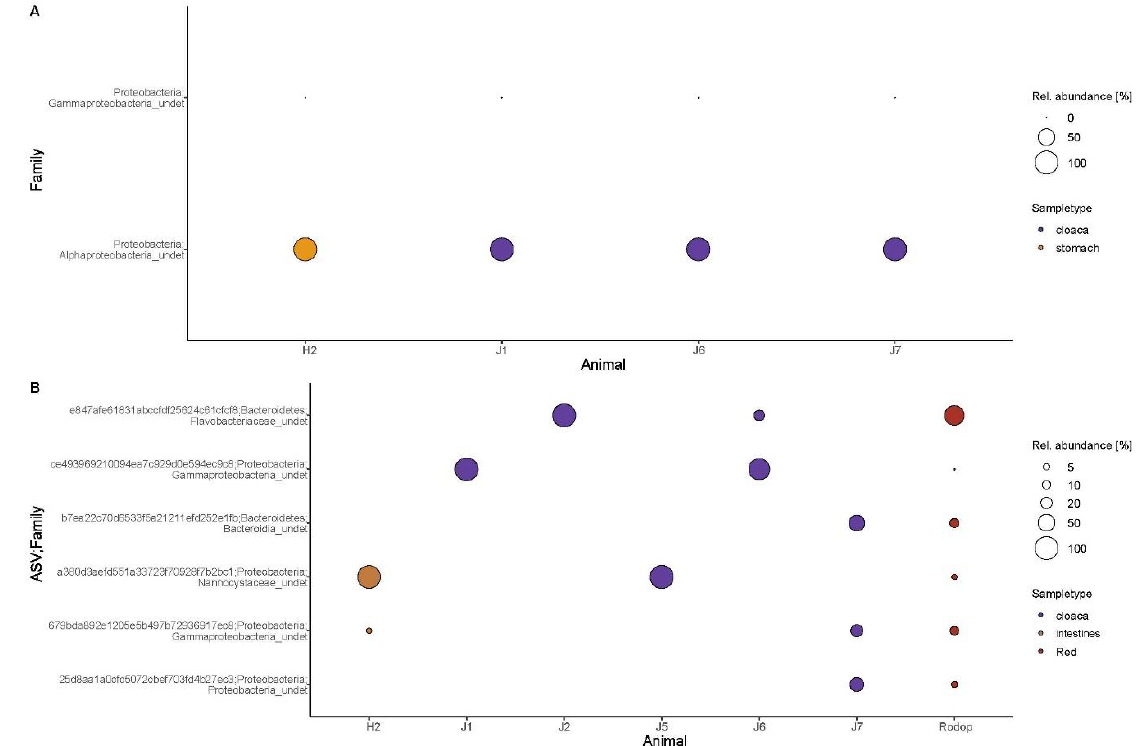
Figure 5. ( A ) Red algae indicator ASVs found in two of the green turtle GI compartments (cloaca: juveniles; stomach: hatchlings). Only two indicator ASVs (Phylum; Family level, Y axis) of red algae were found in only two of the green turtle GI sections: in cloaca and stomach. Presence of each ASV in each turtle individual (Animal) is represented as a circle in relative abundance. Indicator Gammaproteobacteria_undet rel. abundance was <1%. ( B ) Shared bacterial ASVs between red algae and turtle compartments (cloaca: juveniles; intestines: hatchlings). The six shared ASVs and the family level they are identified with are represented in the Y axis. The Animal code in the X axis in both A&B figures, corresponds to the individual ID they were sampled from. Presence of each ASV in each individual is represented as a circle in relative abundance.